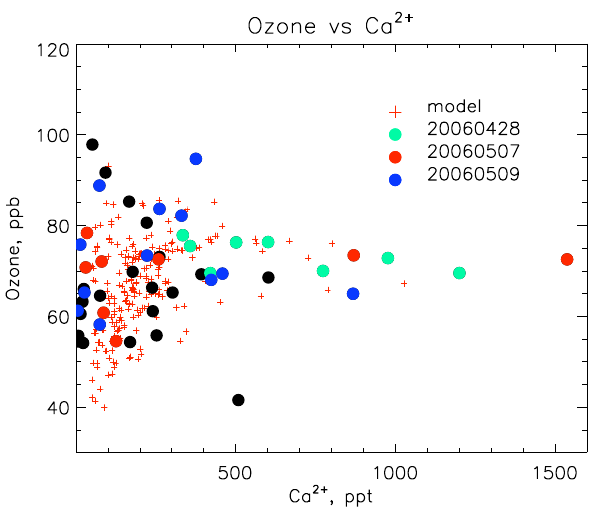
Fig. 8. Relationship between observed ozone and Ca 2 + concen- trations at 4–6km altitude for the INTEX-B flights (filled circles). Observations on days with a large range of Ca 2 + are colored. Cor- responding model results are also shown (red crosses); low Ca 2 + ( < 50ppt) points are excluded for clarity.